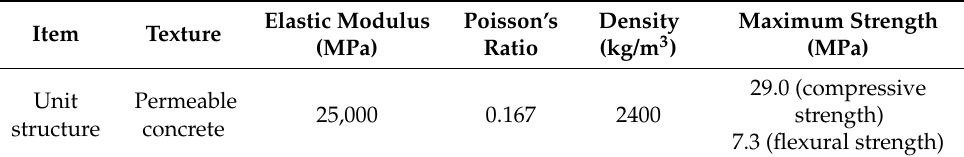
Table 8. Material properties.